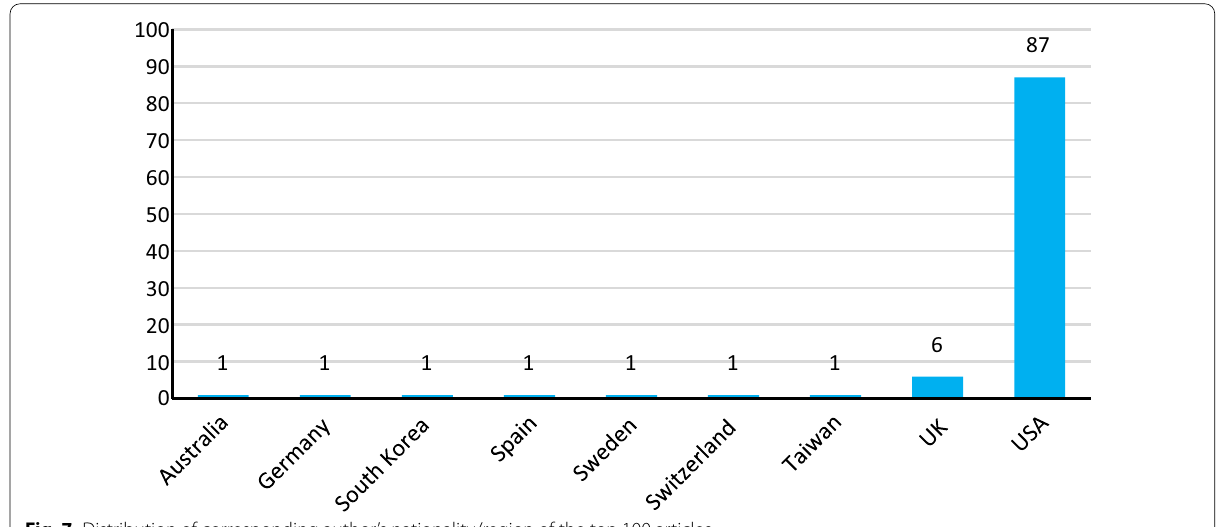
Fig. 7 Distribution of corresponding author’s nationality/region of the top 100